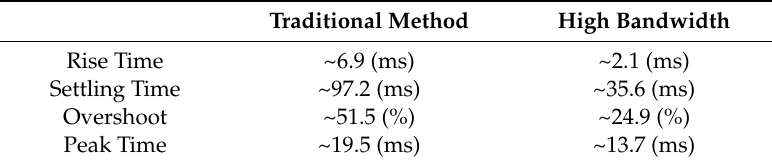
Figure 15. Speed loop step response. Table 4. Speed loop step response parameter.